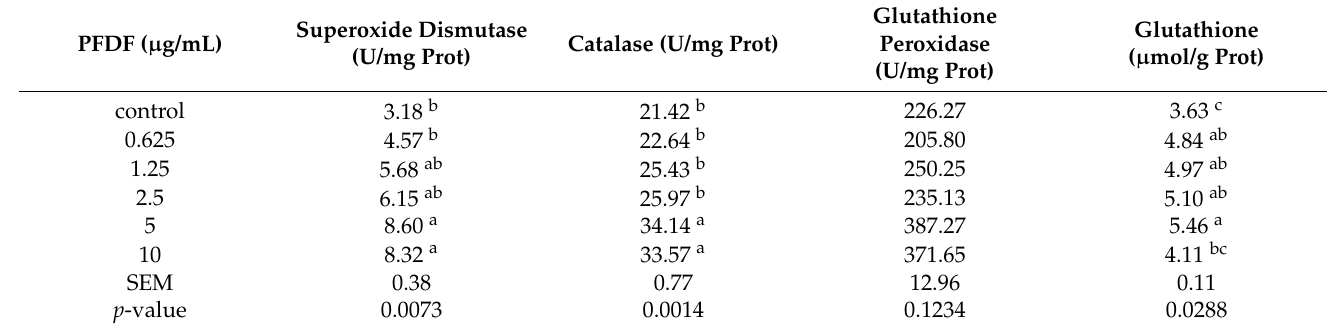
Table 5. Effect of PFDF on antioxidant enzyme activities and GSH level in IPEC-J2